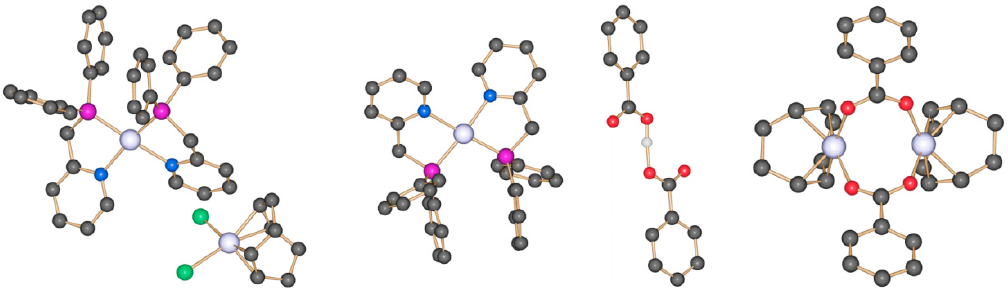
Scheme 2. Schematic representation of the rhodium-catalyzed propargylic CH activation with the ligands DPEPhos, above, and DPPMP, below [41–43].